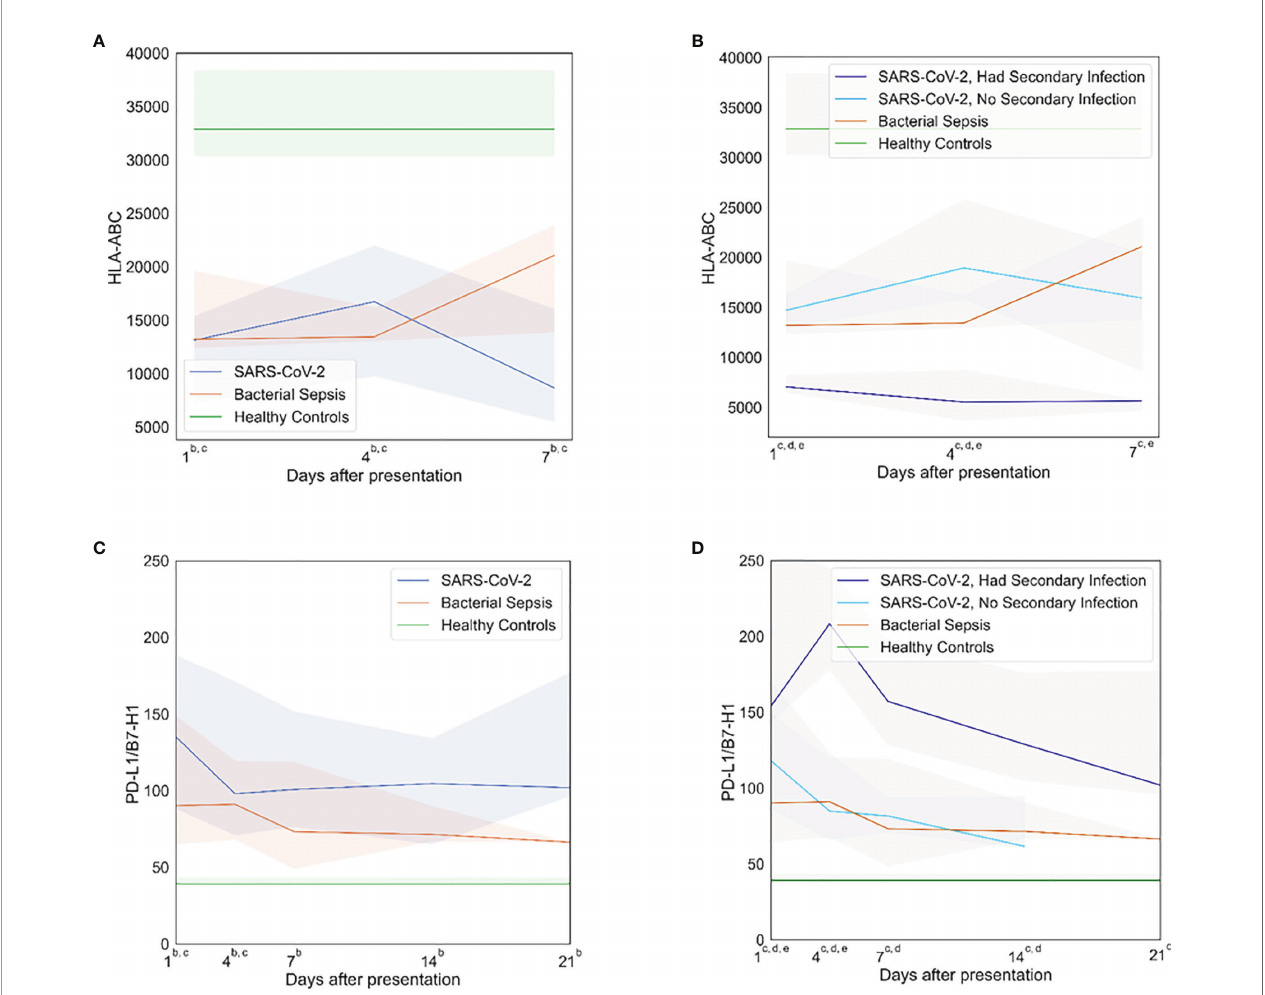
FIGURE 2 | Immunosuppressive pro fi les. Both SARS-CoV-2 and bacterial sepsis were associated with early, persistent immune suppression. SARS-CoV-2 patients who develop secondary bacterial infections represent a distinct subgroup that would be expected to have immunologic pro fi les blending those of SARS-CoV-2 and bacterial sepsis. Subgroup analyses demonstrated that HLA-DR expression was lowest and sPD-L1 were highest among SARS-CoV-2 who developed secondary bacterial infections. (A) Human leukocyte antigen (HLA)-antibodies bound per cell (ABC) over time, primary analysis. (B) HLA-ABC over time, subgroup analysis. (C) Programmed death-ligand (PD-L)-1 over time, primary analysis. (D) PDL-1 over time, subgroup analysis. Data are presented as median values (colored lines) and interquartile ranges (shaded regions). Groups were compared by generalized estimating equations with p-values corrected for multiple comparisons by the Benjamini-Hochberg procedure. At each time point, all available values (as listed in Supplemental Table 2 ) were included in all statistical tests for 30 SARS-CoV-2 patients, 10 bacterial sepsis patients, and 10 healthy control patients. Superscript letters indicate time points at which group comparisons had p ≤ 0.05. For the primary analysis (3 groups): a SARS-CoV-2 vs. Bacterial Sepsis; b SARS-CoV-2 vs. Healthy Controls; c Bacterial Sepsis vs. Healthy Controls. For the subgroup analysis (4 groups): a SARS-CoV-2 with secondary infection vs. Bacterial Sepsis; b SARS-CoV-2 without secondary infection vs. Bacterial Sepsis; c SARS-CoV-2 with secondary infection vs. Healthy Controls; d SARS-CoV-2 without secondary infection vs. Healthy Controls; eBacterial Sepsis vs. Healthy